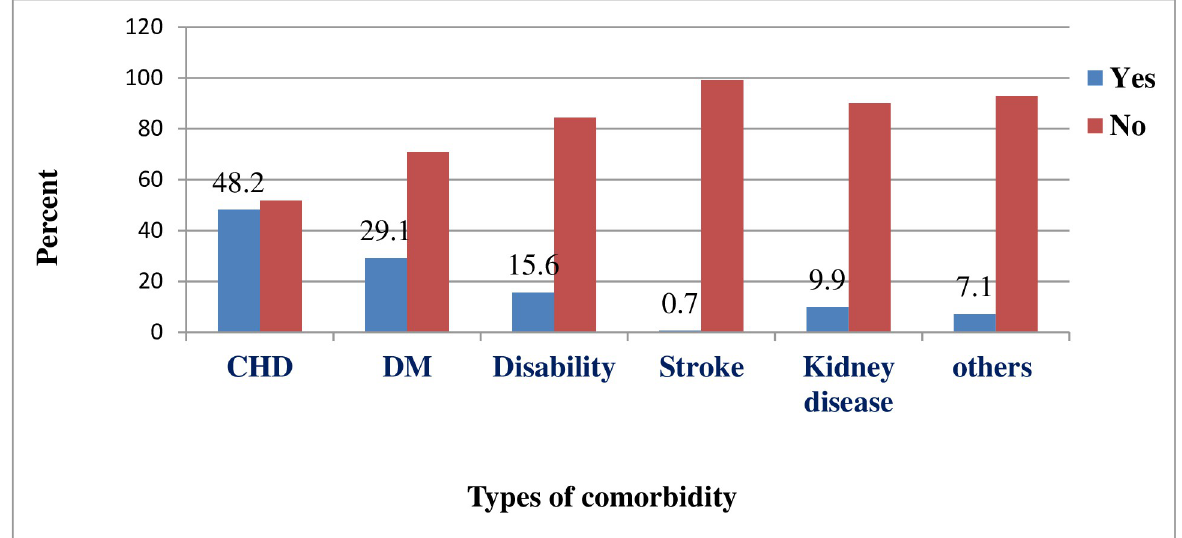
Fig 1. Types of comorbidity among patients admitted with severe COVID-19 cases in WURH treatment center, Western Ethiopia, 2021.